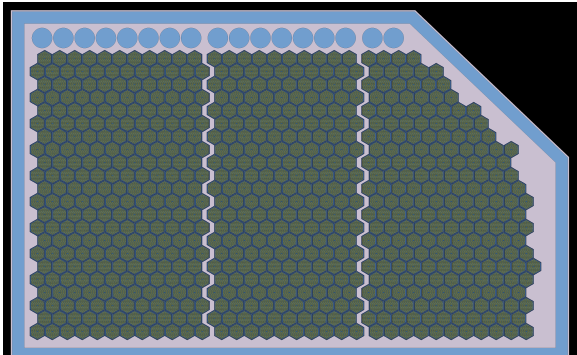
Figure 2. Spent fuel storage pool